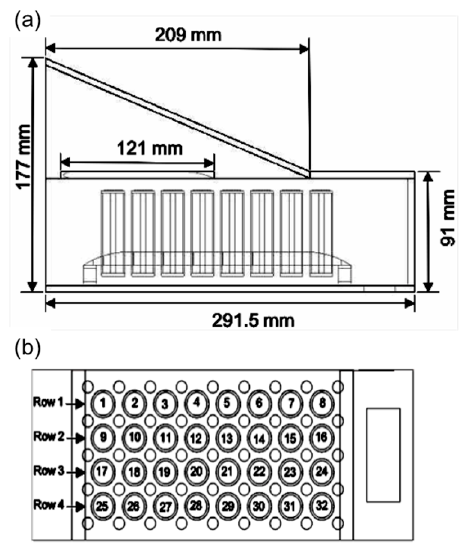
Figure 1. Schematics of the ( a ) battery pack and ( b ) arrangement of cells.